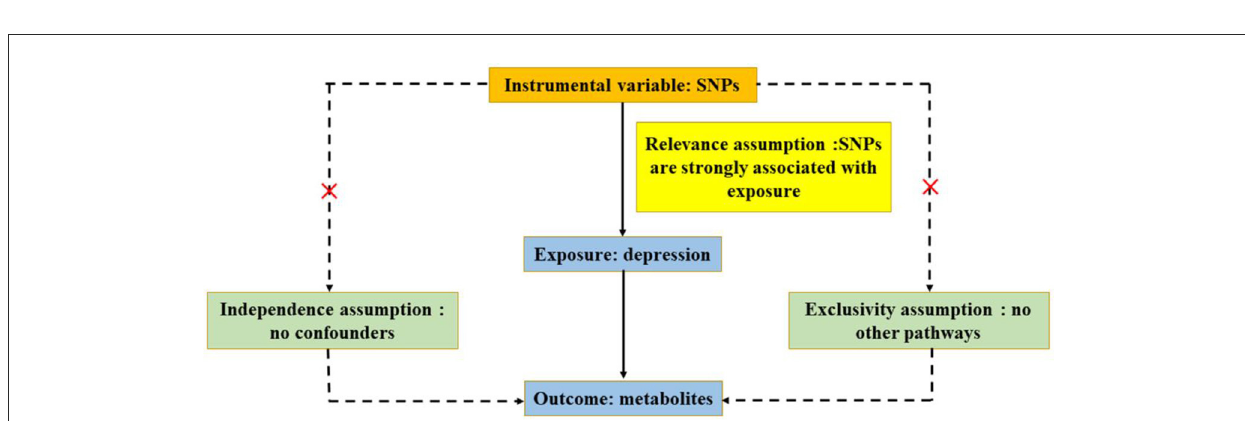
FIGURE2 Three significant assumptions of depression on metabolites via reverse MR. The three paths represent these three different assumptions. Relevance assumption: SNPs are associated with depression (the exposure). Independence assumption: SNPs are completely independent of any potential confounding factors that influence depression and metabolites. Exclusivity assumption: SNPs affect metabolites only through depression (exposure) and not via any alternative causal